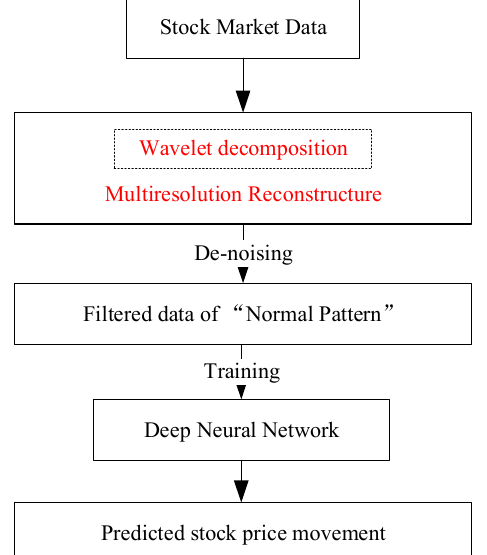
Figure 3. The flowchart of the proposed algorithm.